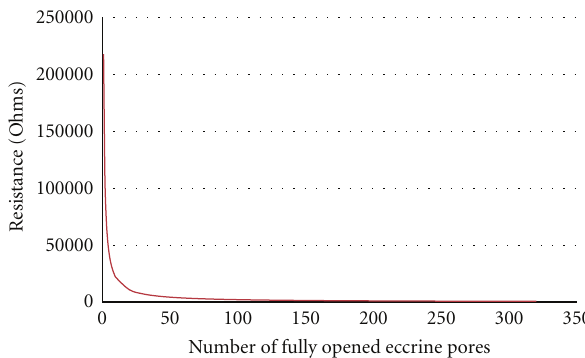
Figure 3: Epidermal resistance as a function of number of sweat filled